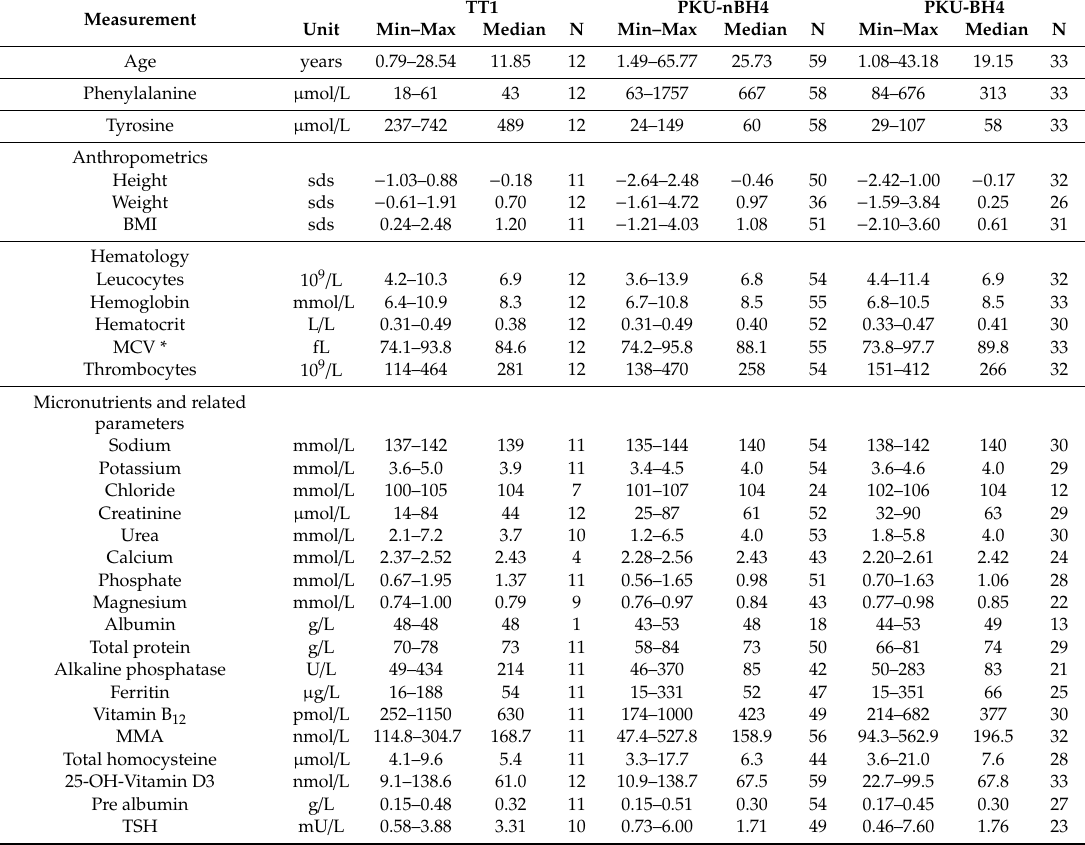
Table 1. Descriptive data. For each patient group the minimum and maximum observed values were included, as well as the number of patients for which that value was